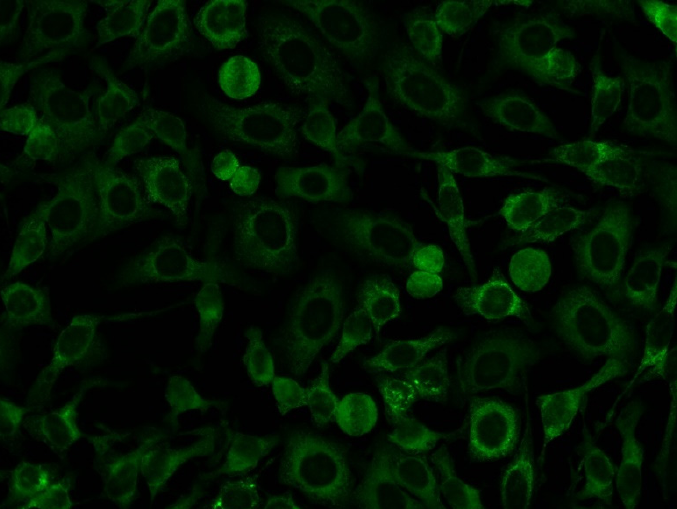
Figure 4. Example of the indirect immunofluorescence pattern (AC-19/20) on HEp-2 cells from a serum sample having high levels of anti-OJ antibodies identified by immunoprecipitation.